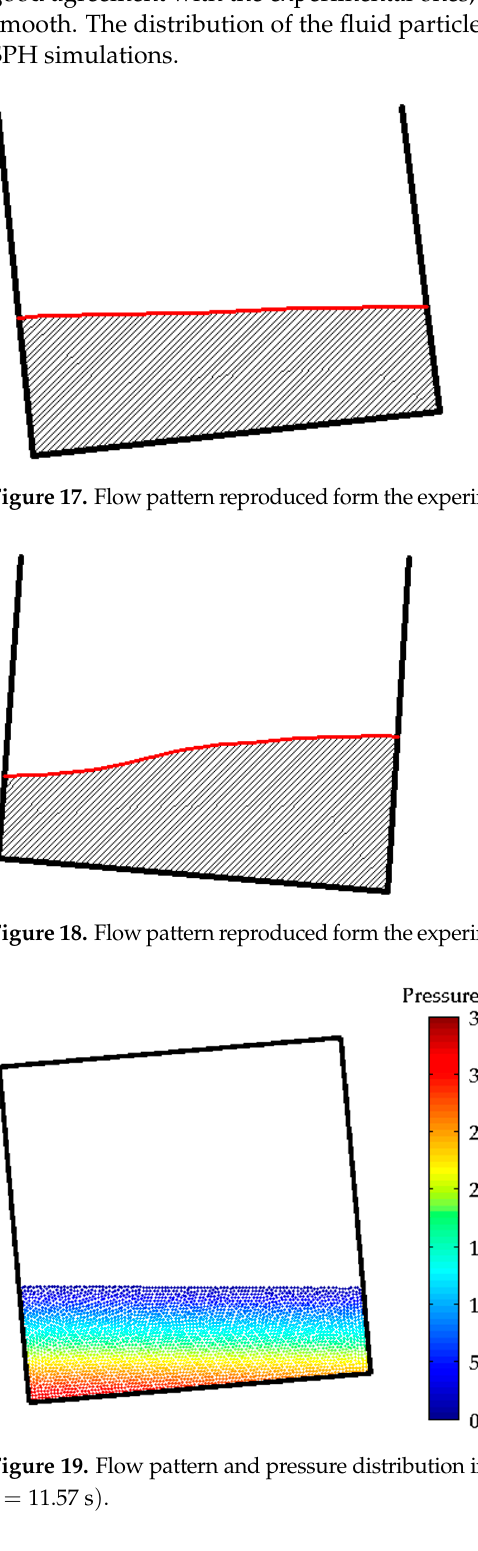
Figure 20. Flow pattern and pressure distribution in the SPH simulation (